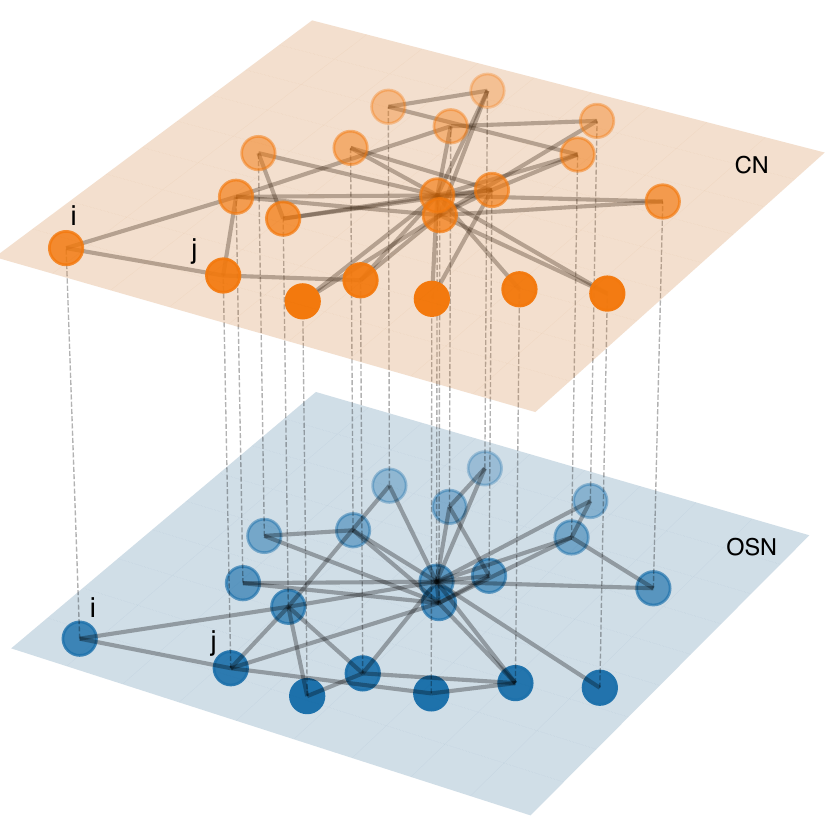
Figure 1. A two-layers representation of our model: online social network (OSN) and credibility network (CN)